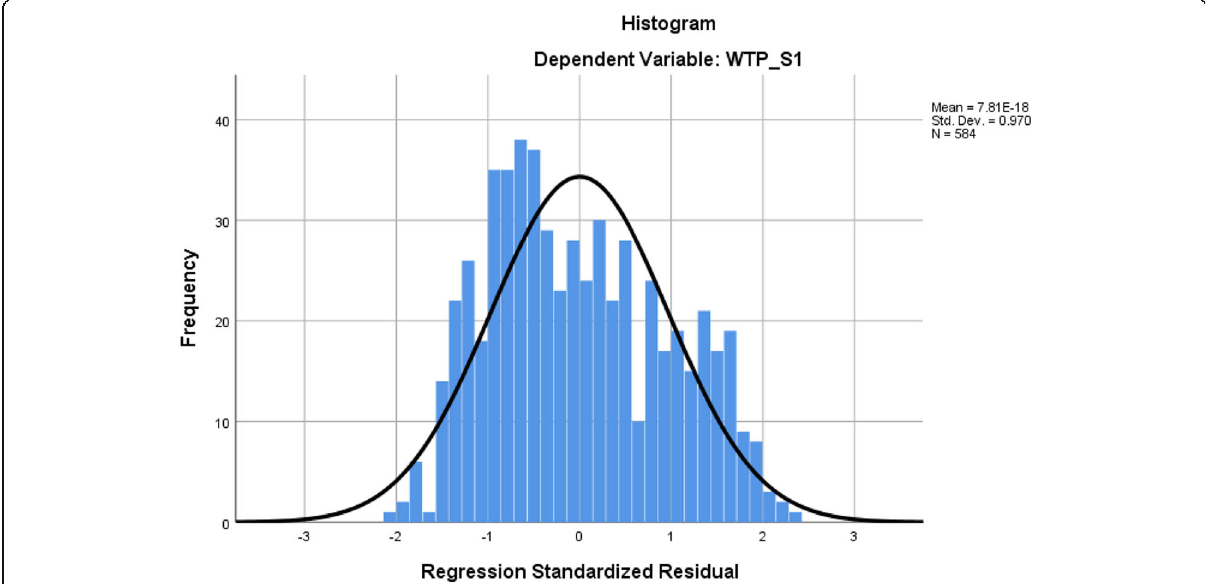
Fig. 7 Histogram of the residuals of regression of Model A (explanatory variables against WTP for PAV)